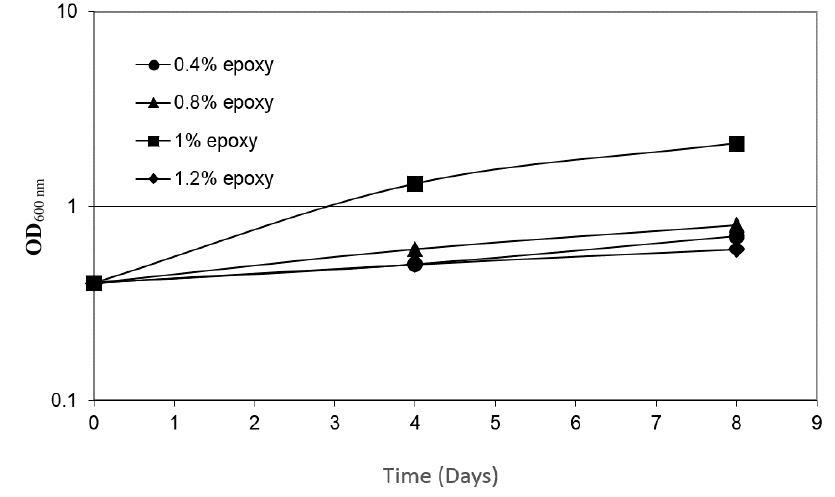
Figure 3. The dependence of bacterial growth rate on the concentration of LY 5052 epoxy resin. Each experiment was repeated at least five times; a typical result is shown here.